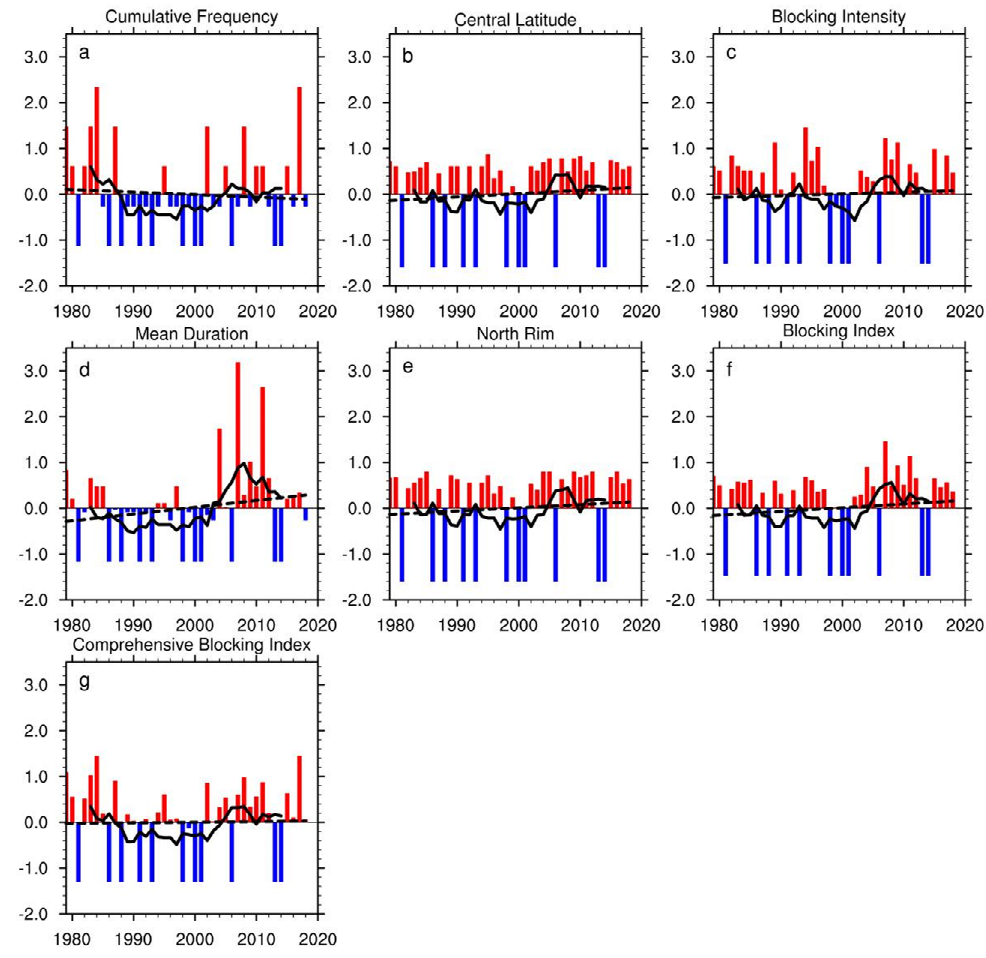
Figure 1. Interannual change characteristics of the UB in winter from 1979 to 2019. (Normalized: Fq black line represents the result of a 9-point smoothing average, and the black dotted line represents the trend.)